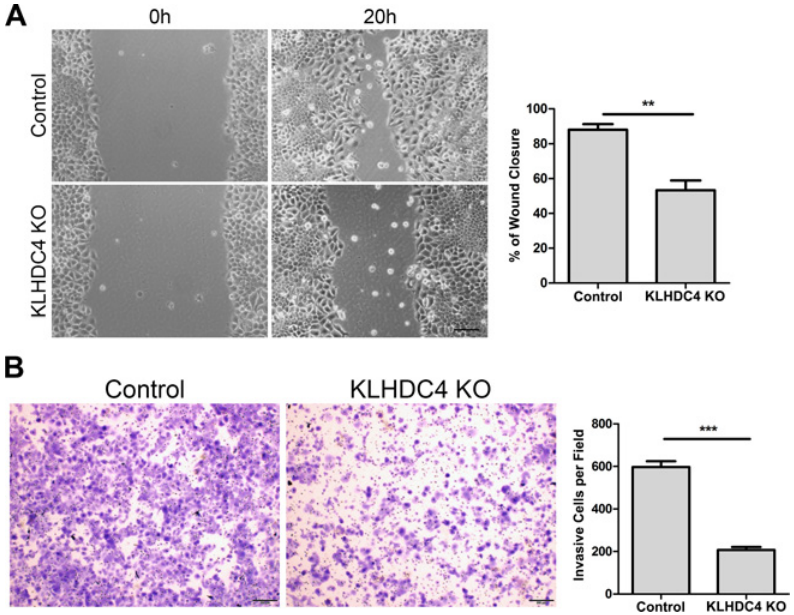
Fig 4. Loss of KLHDC4 reduces NPC cell migration and invasion. (A) Wound-healing assays were performed at 0 and 20 hours with control and KLHDC4 KO cells. Left panels: representative images; Scale bars: 50 μ m. Right panels: quantification of the wound closure area calculated by measuring the decreaseinthe wound bed surface overtime. ** P < 0.01. (B) KLHDC4 KO significantly reduced the invasive ability of CNE2 cells. Left panels: representative images; Scale bars: 50 μ m. Right panels: quantification of average number of cells per field. *** P < 0.001.